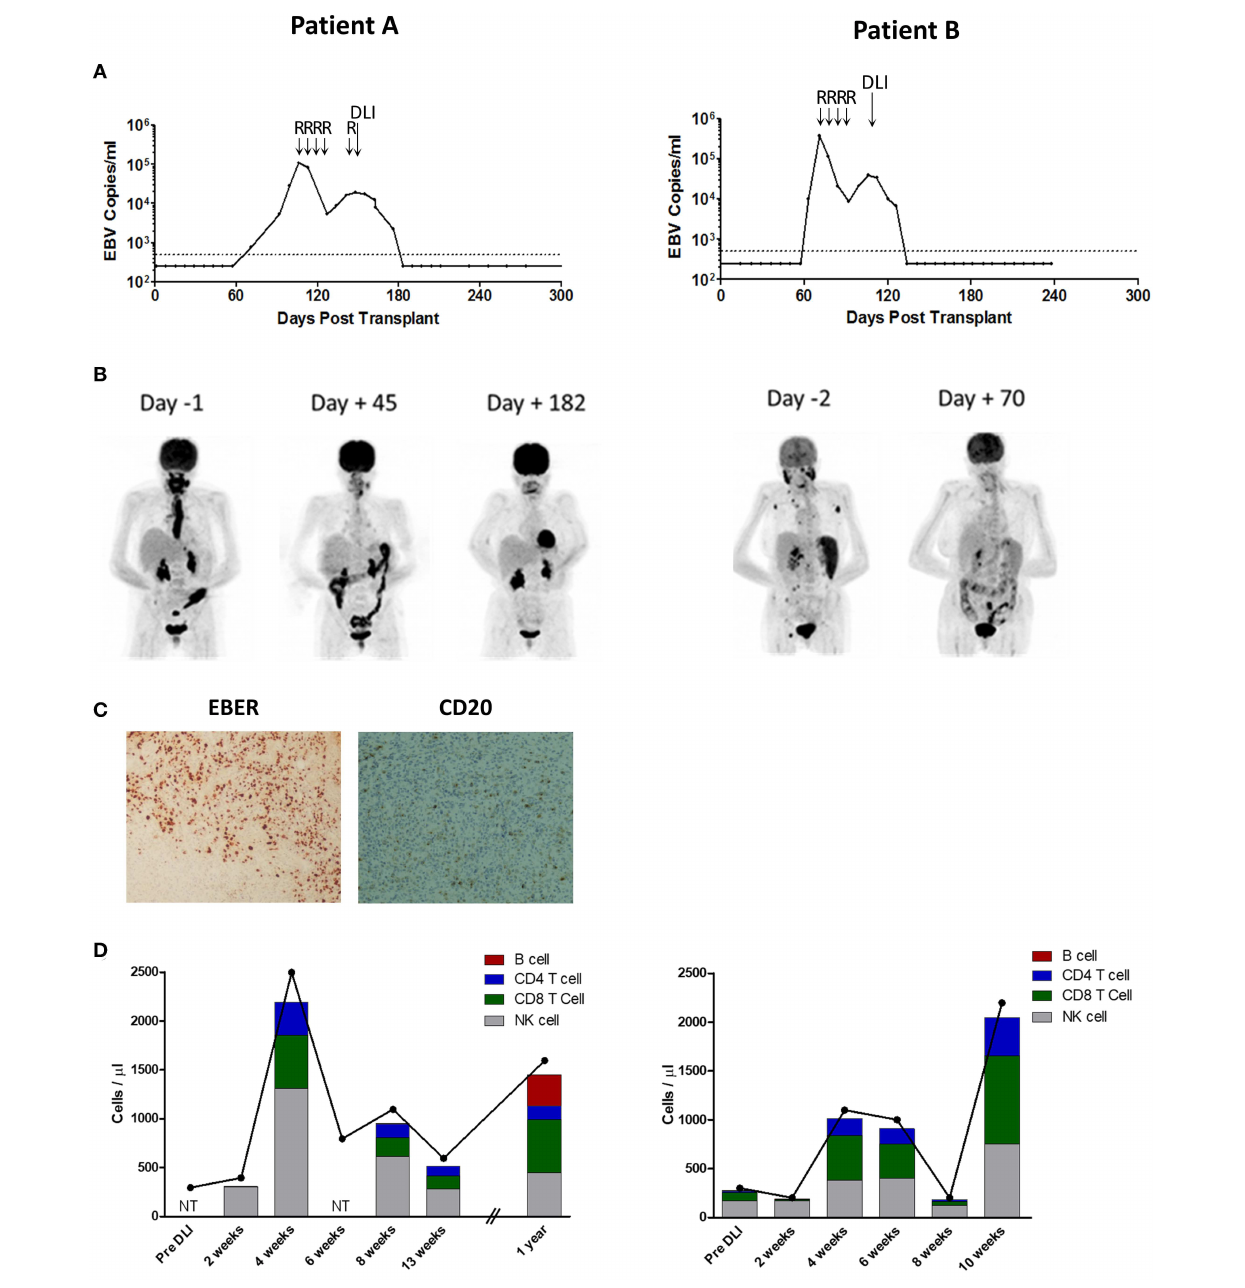
FIGURE 1 | Patient A (Left) and B (Right) Investigations. (A) EBV loads in whole blood, measured by EBV qPCR, and shown as EBV copies/ml whole blood. Day 0 represents the time of second transplant. The dotted line represents the 500 copies/ml threshold of sensitivity for the EBV qPCR assay, below which values are arbitrarily shown as 250 copies/ml. R indicates infusion of Rituximab 375 mg/m 2 ; DLI, donor lymphocyte infusion of 1.0 × 10 6 /Kg. (B) Positron emission tomography images taken pre and post-DLI infusion (Day 0). Patient A had active disease principally located in the oropharynx and esophagus. Patient B had active disease in the oropharynx, spleen and lymph nodes. (C) Analysis of formalin-fixed, paraffin-embedded diagnosis biopsy tissue sections from Patient A showing widespread positivity for EBERs on in situ hybridization but predominantly negative immunohistochemistry for CD20. Images are 40X magnified. (D) Kinetics of total lymphocyte (joined dots) and main lymphocyte subset counts (stacked columns), pre and post-DLI infusion. NT indicates not tested. Expansion of T-cell and NK-cell subsets was observed at 4 weeks after DLI in both patients. peptide and CD4 + peptide pool (a composite of lytic antigens undetectable. Epitope-specific CD4 + T-cells were also detected plus EBNA3C peptides) in Patient B. Interestingly, CD4 + T- in both patients, most evidently against the pool of CD4 + cell responses may have preceded those of CD8 + T-cells latent epitope peptides in Patient A, and the MVF (EBNA1)